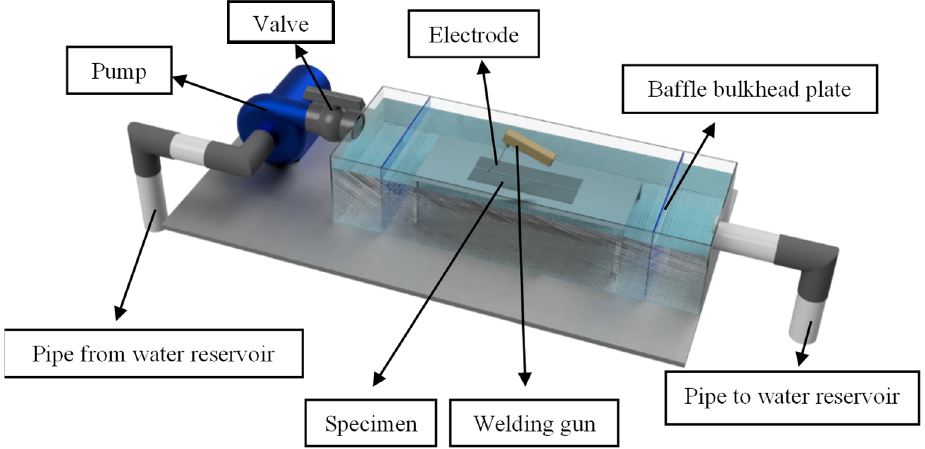
Figure 3. Scheme of water flow simulation glass box.